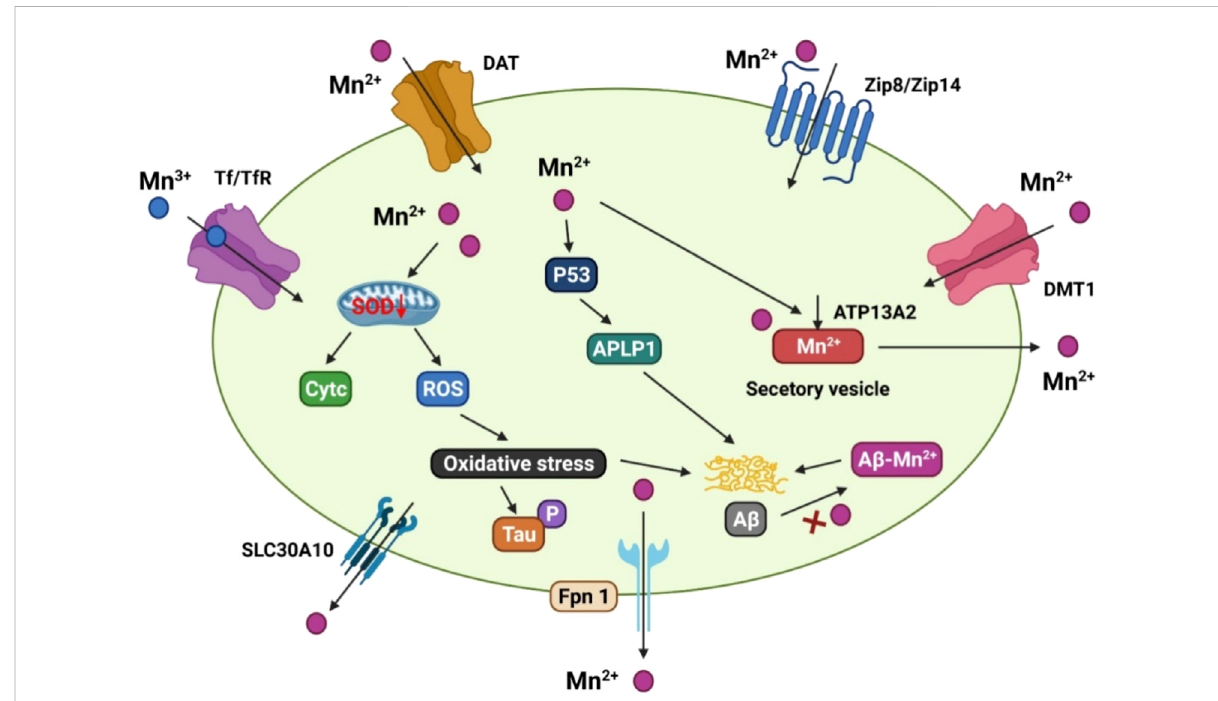
The manganese transport mechanism, and its association with Alzheimer ’ s disease. DMT1, ZIP8/ZIP14, and dopamine transporter (DAT) are involvedforMn 2+ in fl owonthecellmembrane,whereasTf/TfRmediatesMn 3+ entranceintotheendosomeviaendocytosisandisthenreleasedinto the cytoplasm by DMT1. SLC30A10 and Fpn, on the other hand, transport Mn 2+ out of cells. ATP13A2 and SPCA1 also transport Mn 2+ into the lysosomes and Golgi for bioavailability, or produce secretory vesicles that aid Mn 2+ ef fl ux. Mn 2+ conditions can cause mitochondrial oxidative stress in the AD brain, which accelerates tau phosphorylation. In addition, elevated Mn 2+ levels boost the production of p53 and its transcriptional target gene, amyloid-b precursor-like protein 1 (APLP1), which encodes amyloid precursor protein (APP). The production of A β peptides is aided by enhanced APLP1 expression. Mn 2+ could potentially attach to A β and help its